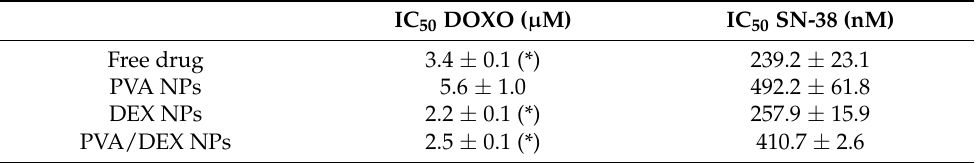
Table 3. IC 50 values of either DOXO ( µ M) or SN-38 (nM) for the three different delivery systems and the free drugs, after 72 h (in the case of DOXO) and 120 h (in the case of SN-38) incubation with MCF-7 cells. (*) The difference between the IC 50 values of cells incubated with free DOXO and with either DEX or PVA/DEX NPs loaded with DOXO was statistically significant ( p <